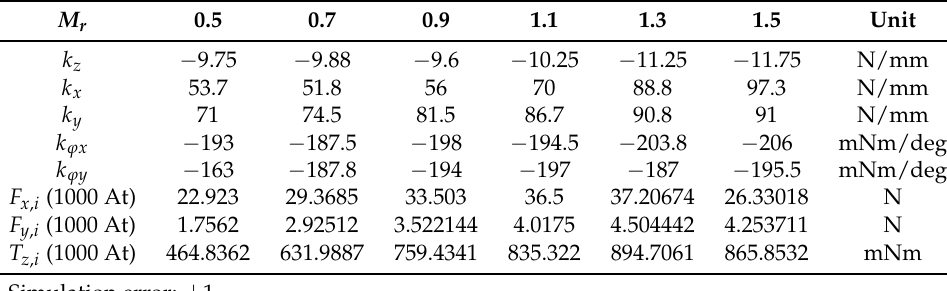
Table 10. Simulation results for different values of M r